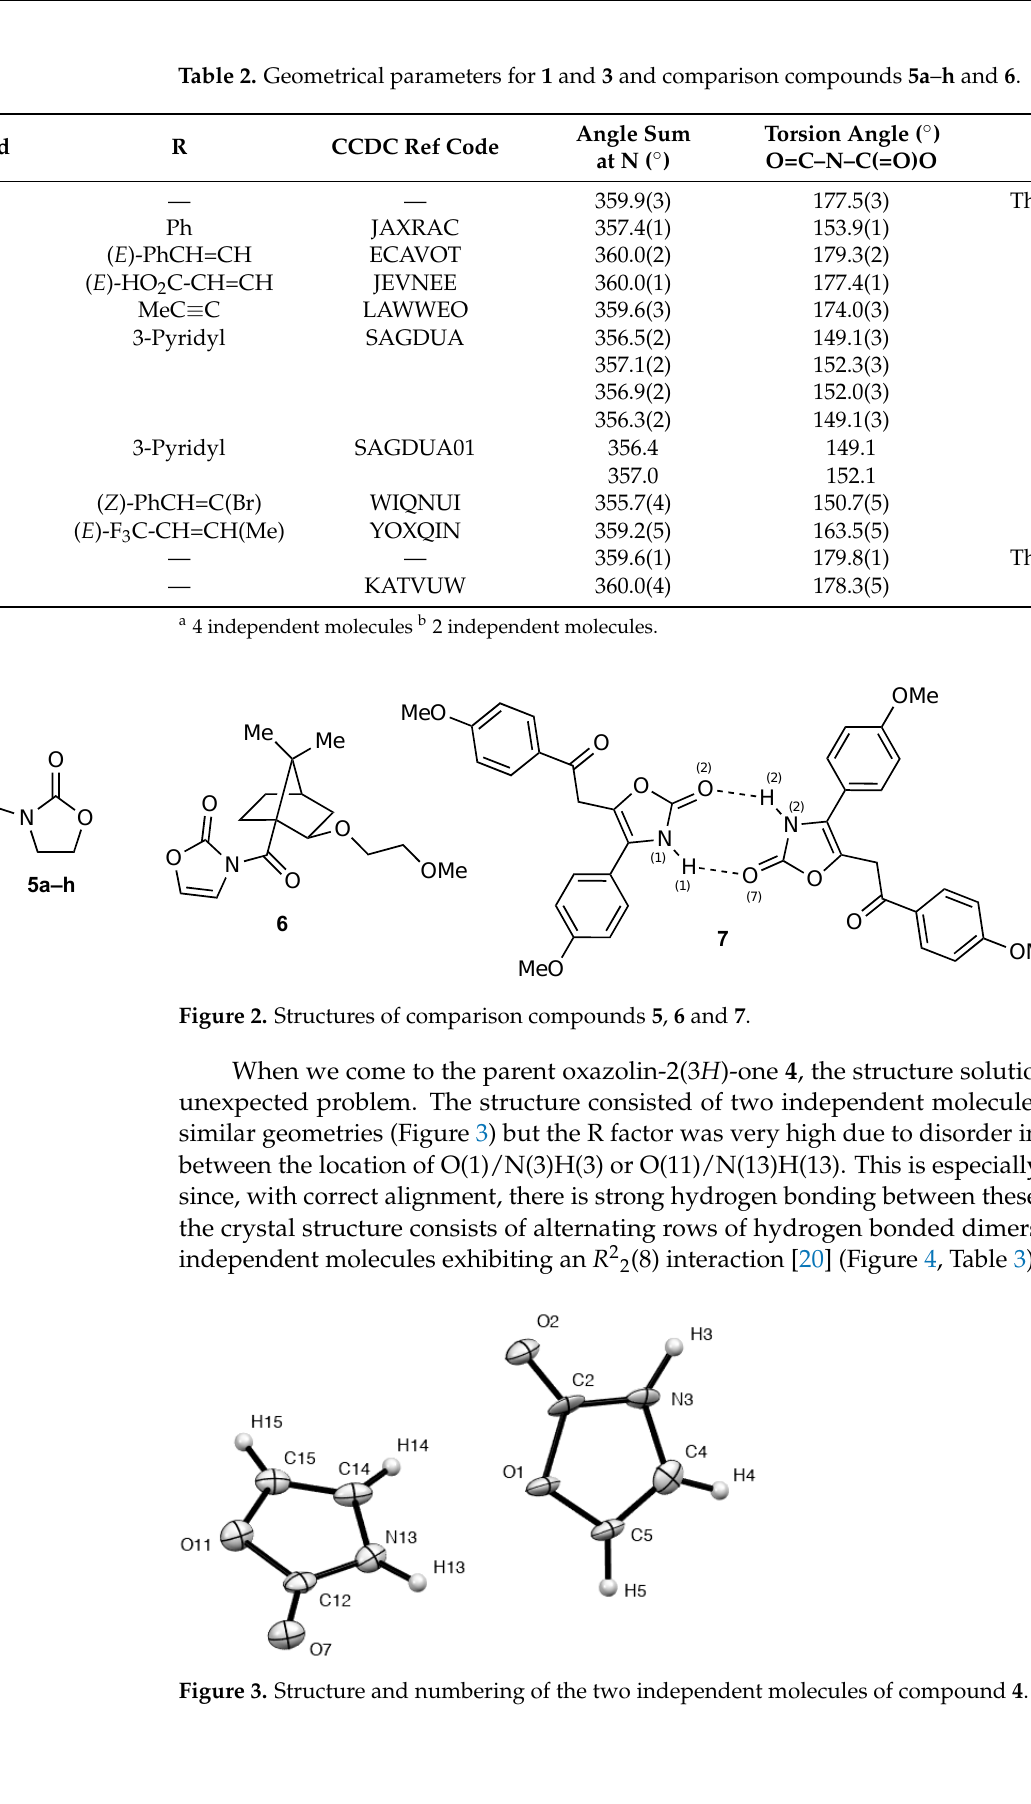
Figure 4. Hydrogen bonding pattern for compound 4 viewed along the b axis. Table 3. Hydrogen bonding parameters for 4 and comparison compound 7 (Å , °). Compound